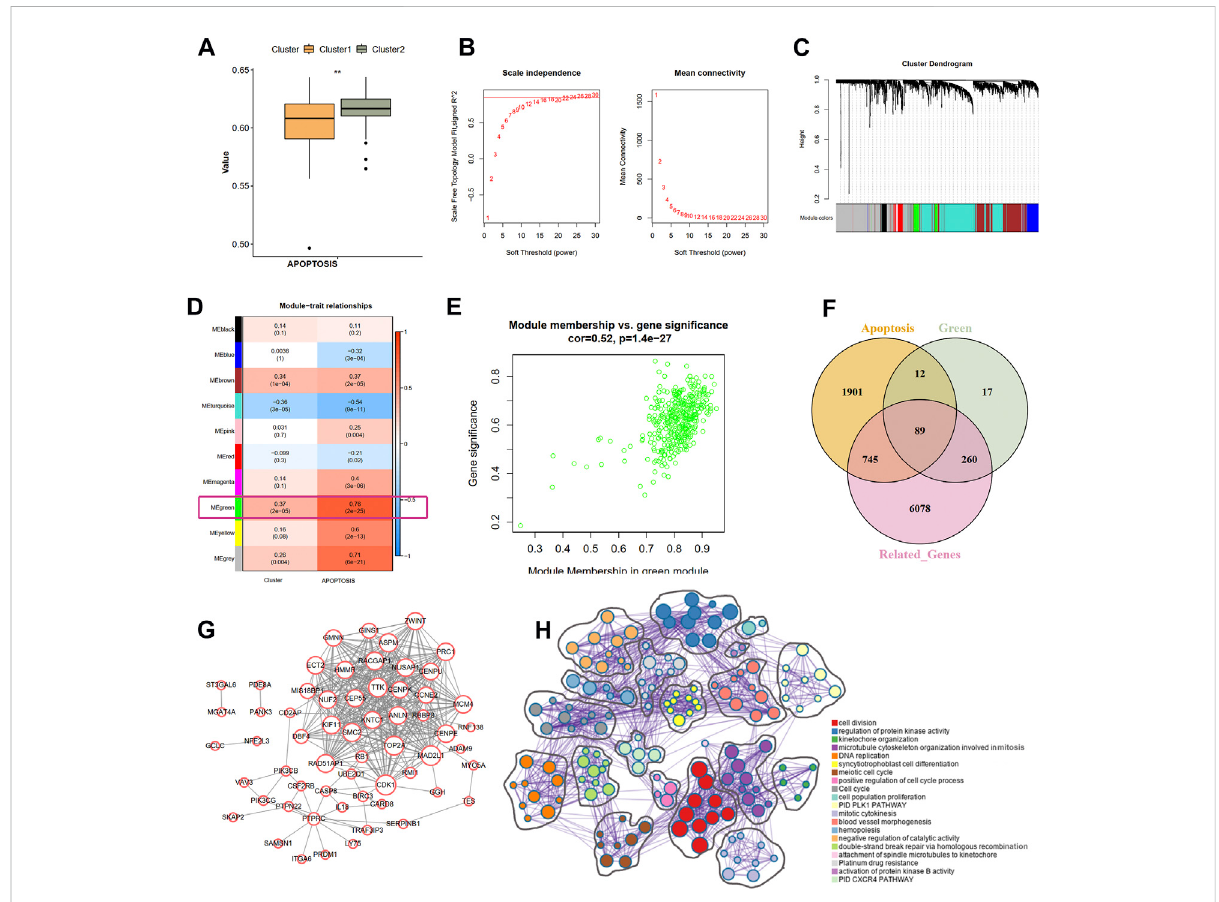
FIGURE 6 Identi fi cation of thecorrelation of apoptosis-related genes and nine IRGs. (A) The difference scores ofapoptosis process between two clusters with GSVA analysis. (B) Correlation between soft threshold power and scale-free topology model with WGCNA analysis. (C) Cluster tree of coexpression moduleswith WGCNA analysis. Different colorsrepresent differentmodules. (D) The module-trait relationships with WGCNA analysis. (E) Screening the green module as the key module. (F) Intersecting the apoptosis-related genes correlated with nine IRGs. Apoptosis indicates the apoptosis-related genes in MSigDB database. Green means the green module genes in WGCNA analysis. Related-genes mean those genes correlated with nine IRGs in GSE21545 dataset. (G) Protein-protein network of apoptosis-related genes. (H) The biological function of apoptosis- related genes. Different colors indicate different